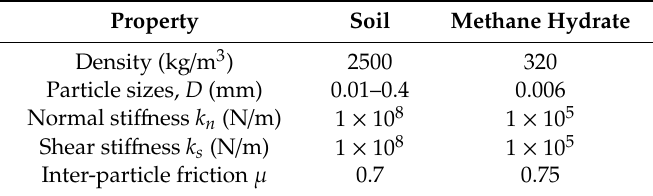
Table 1. Mechanical parameters of particles in the simulation.